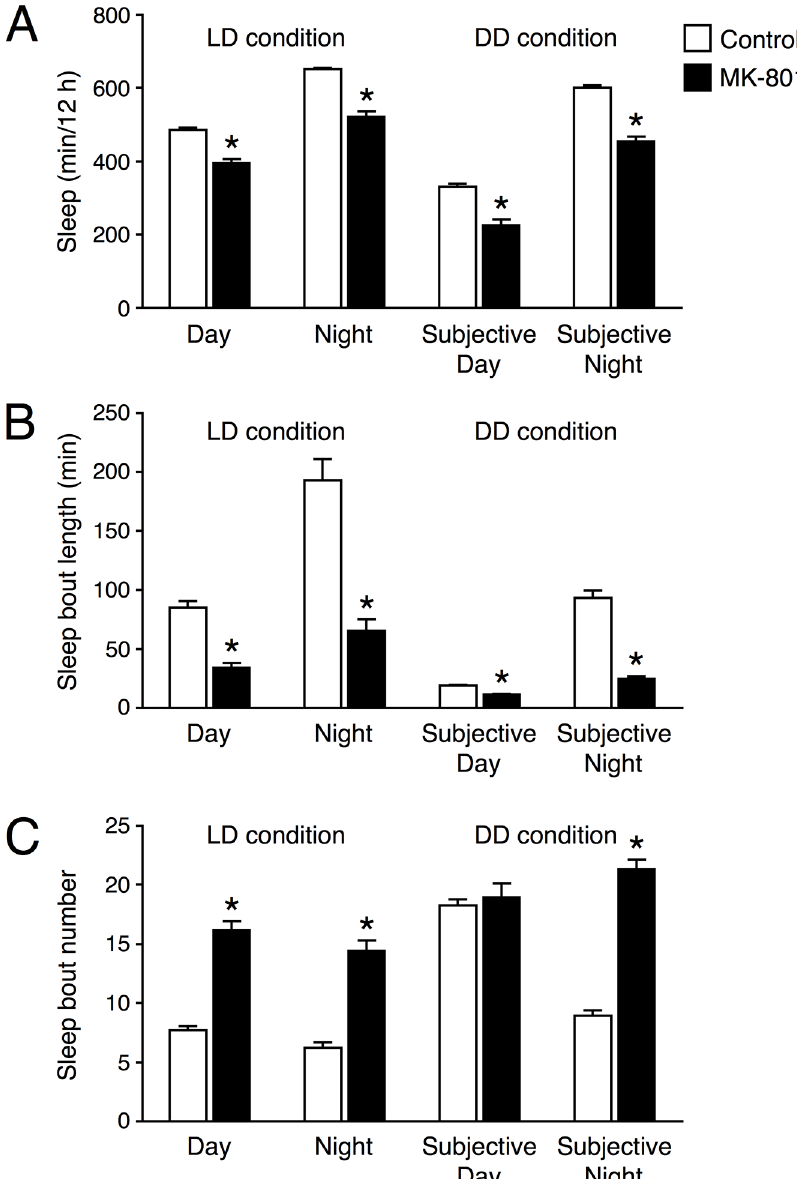
0 – 12), night (ZT 12 – 24), subjective day (CT 0 – 12) and subjective night (CT 12 – 24). Data are presented as mean ± SEM. Asterisks indicate statistically significant differences from control determined by a t -test ( p <